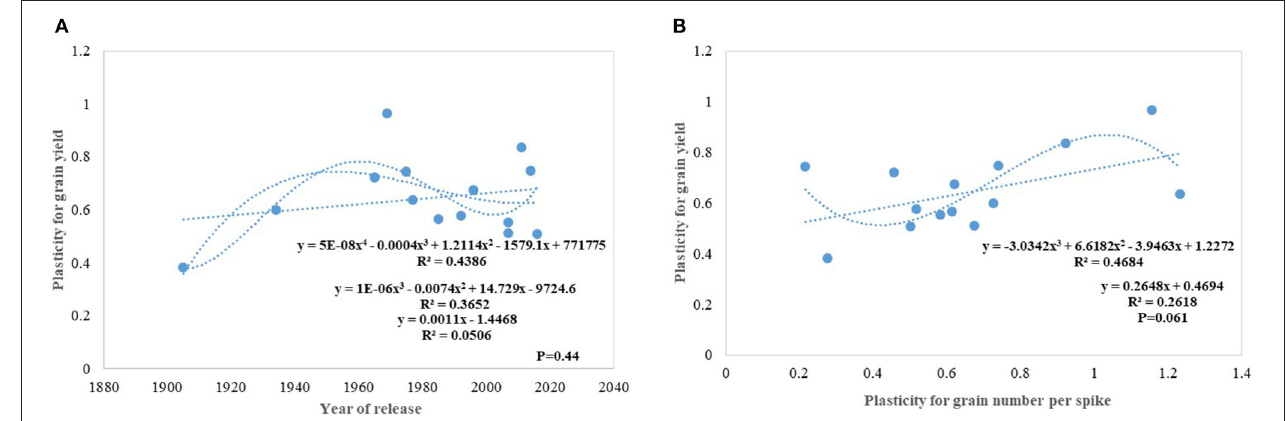
FIGURE 10 | Trait plasticity for grain yield (A) and its linear relation with grain number (B) in wheat genotypes. cultivars, Kalyan Sona, PBW 343, HD 2967, and HD